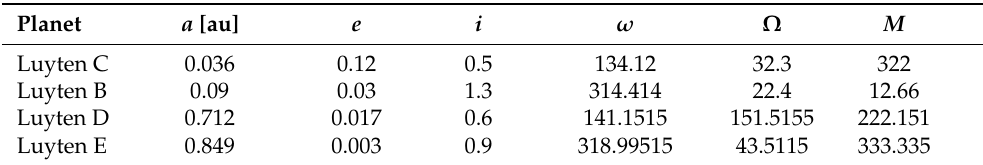
Table 3. Osculating elements of the four Luyten planets. Note that all angles are in units of degrees. M is mean